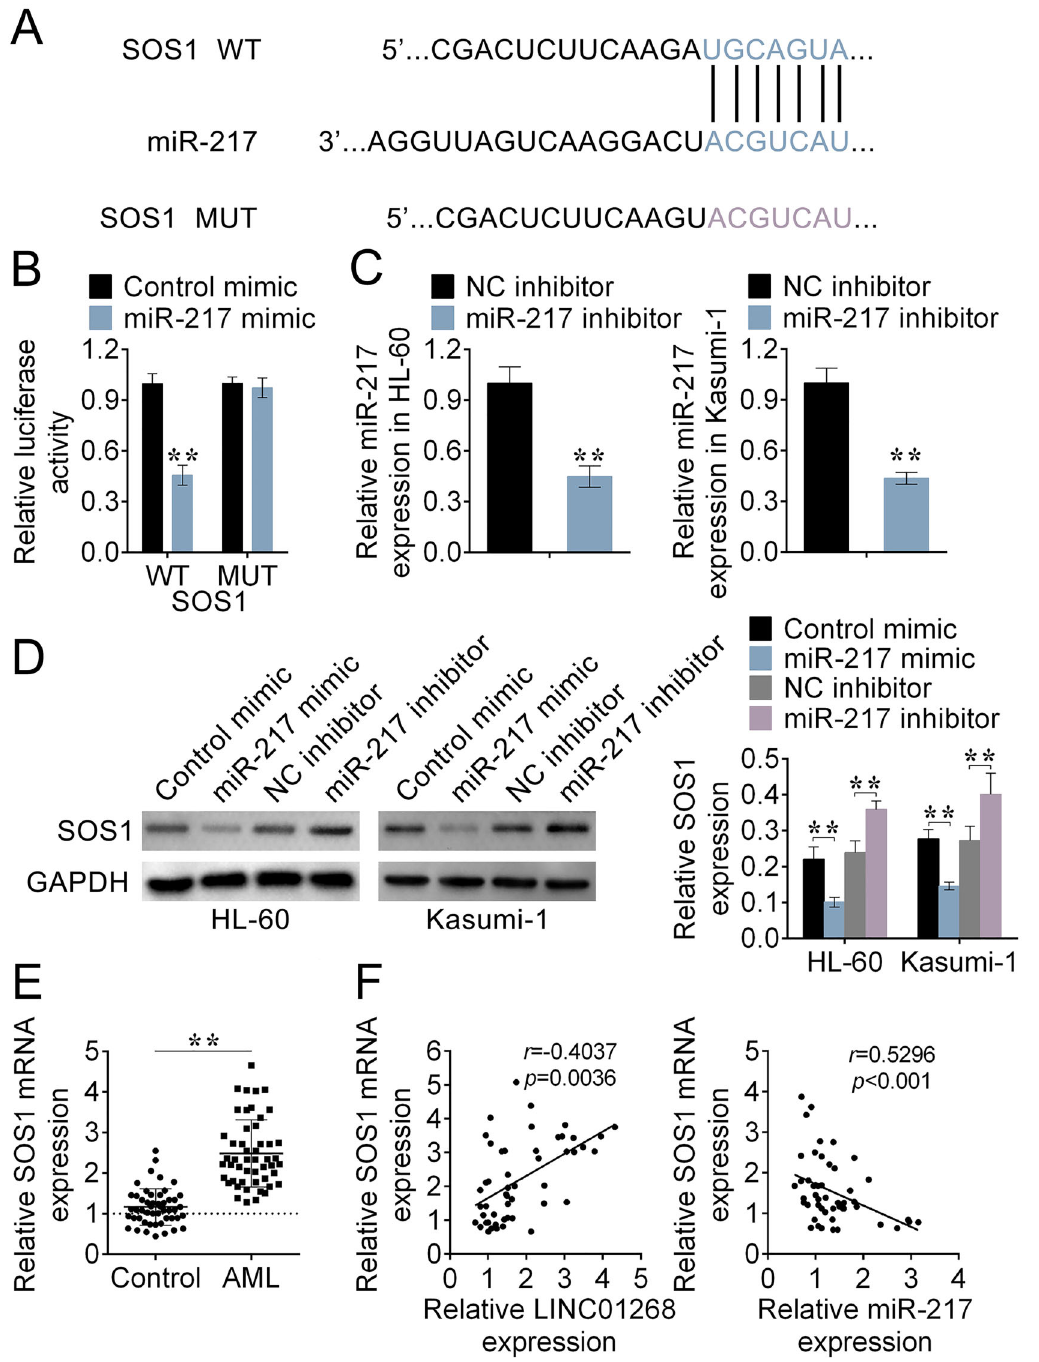
Figure 4. SOS1 was a target of miR-217. A , The relationship between miR-217 and SOS1 was predicted by TargetScan software. B , The luciferase activity of the reporter with SOS1 wild type (WT) or mutated (MUT) was evaluated by the luciferase reporter assay. C , After the transfection of miR-217 inhibitor, the expression of miR-217 in HL-60 and Kasumi-1 cells was measured by qRT-PCR. D , After acute myeloid leukemia (AML) cells were transfected with miR-217 mimic, control mimic, miR-217 inhibitor, or negative control (NC) inhibitor, the protein expression of SOS1 was determined by western blot. E , The expression of SOS1 in bone marrow tissues from AML patients and healthy donors was calculated by qRT-PCR. F , The correlation among SOS1, miR-217, and LINC01268 was evaluated by the Pearson correlation analysis. Data are reported as means ± SD. **P o 0.01 vs the control group (ANOVA and t